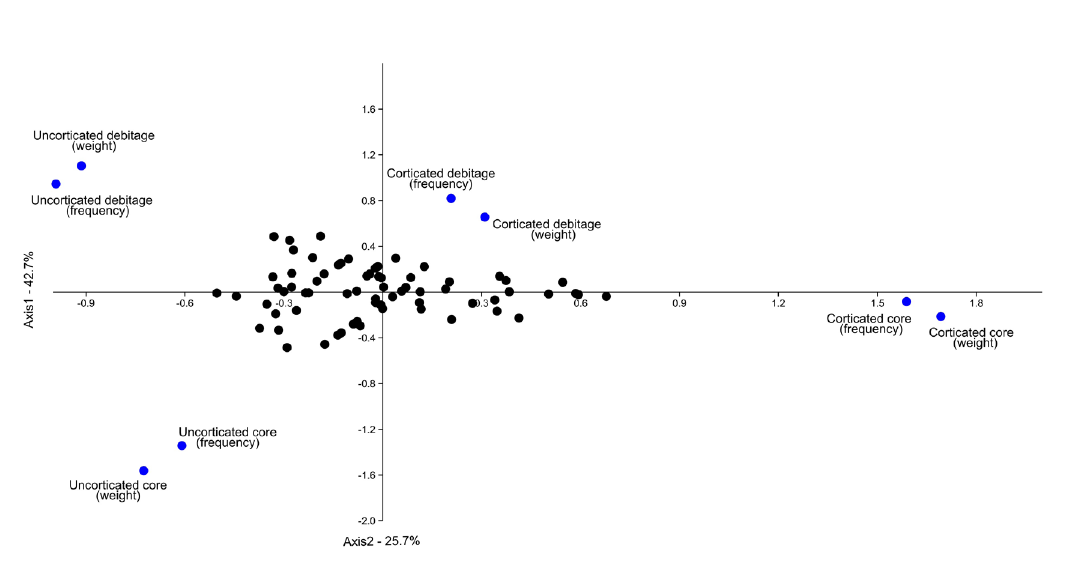
Figure 5: Correspondence analysis of Type 2 limnosilicite and the plot according to the first and second